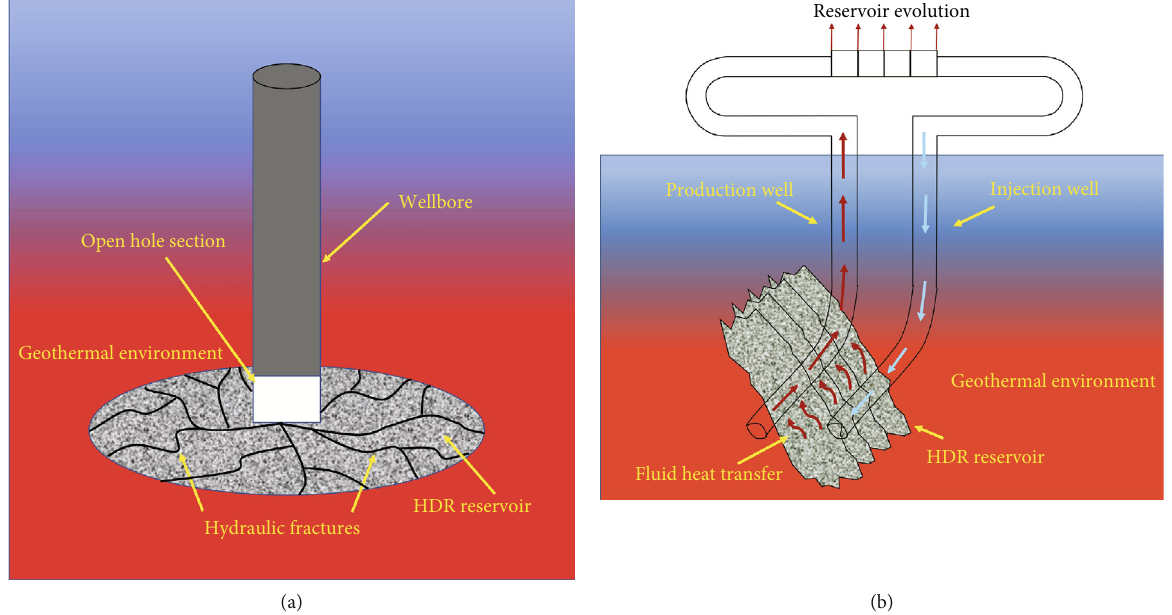
Figure 9: Granite fracturing mechanism under real-time high-temperature conditions [23, 33]: (a) hydraulic fracturing; (b) fl uid heat